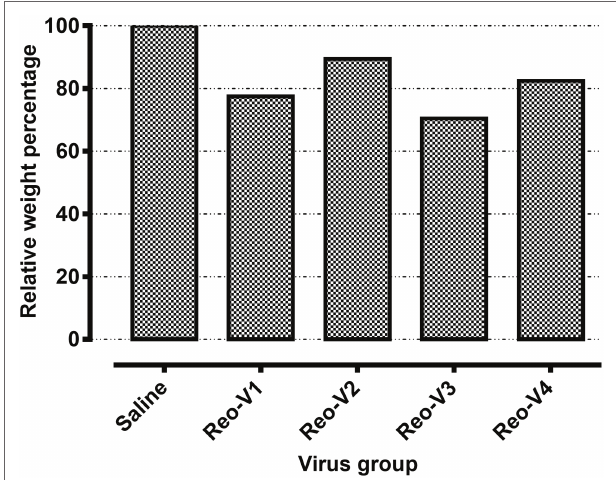
FIGURE 5 | Relative weight percentages of the birds infected with the indicated ARVs from different genotype cluster groups [i.e., Reo-V1 (Cluster-5), Reo-V2 (Cluster-4), Reo-V3 (Cluster-2), or Reo-V4 (Cluster-6)] at day 45 post-infection. The relative mean body weight in the infected group was calculated by taking the mean weight of the control group as a standard.